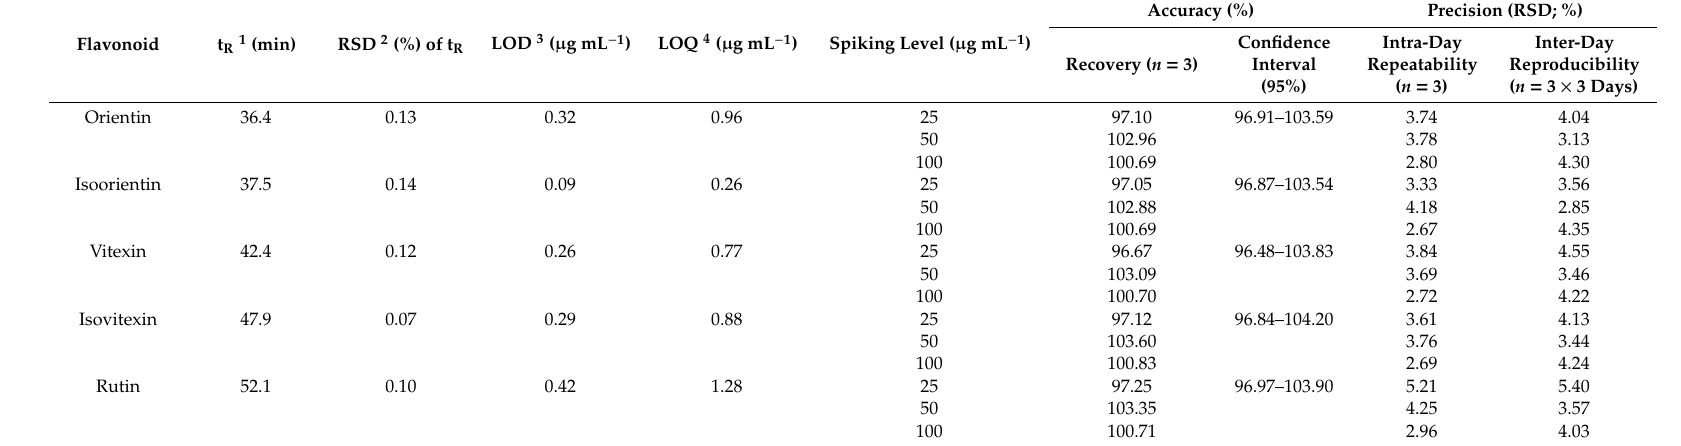
Table 3. Validation data for the simultaneous analysis of flavonoids in common buckwheat sprout extract using